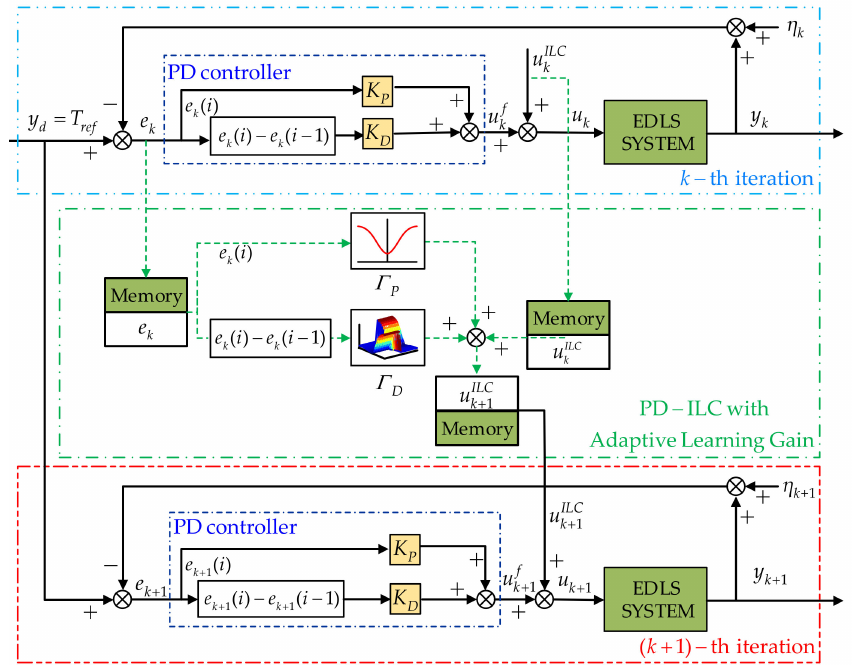
Figure 2. Block diagram of the electric dynamic load simulator system based on proportional– derivative (PD)-type iterative learning control with adaptive learning